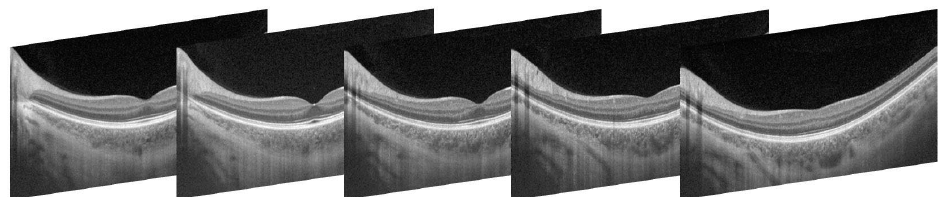
Figure 1. Set of raw OCT fundus images (B-scans) provided by the instrument in one of the participants. The separation among images was 0.15 mm. The left side of each panel corresponds to the nasal retinal location.